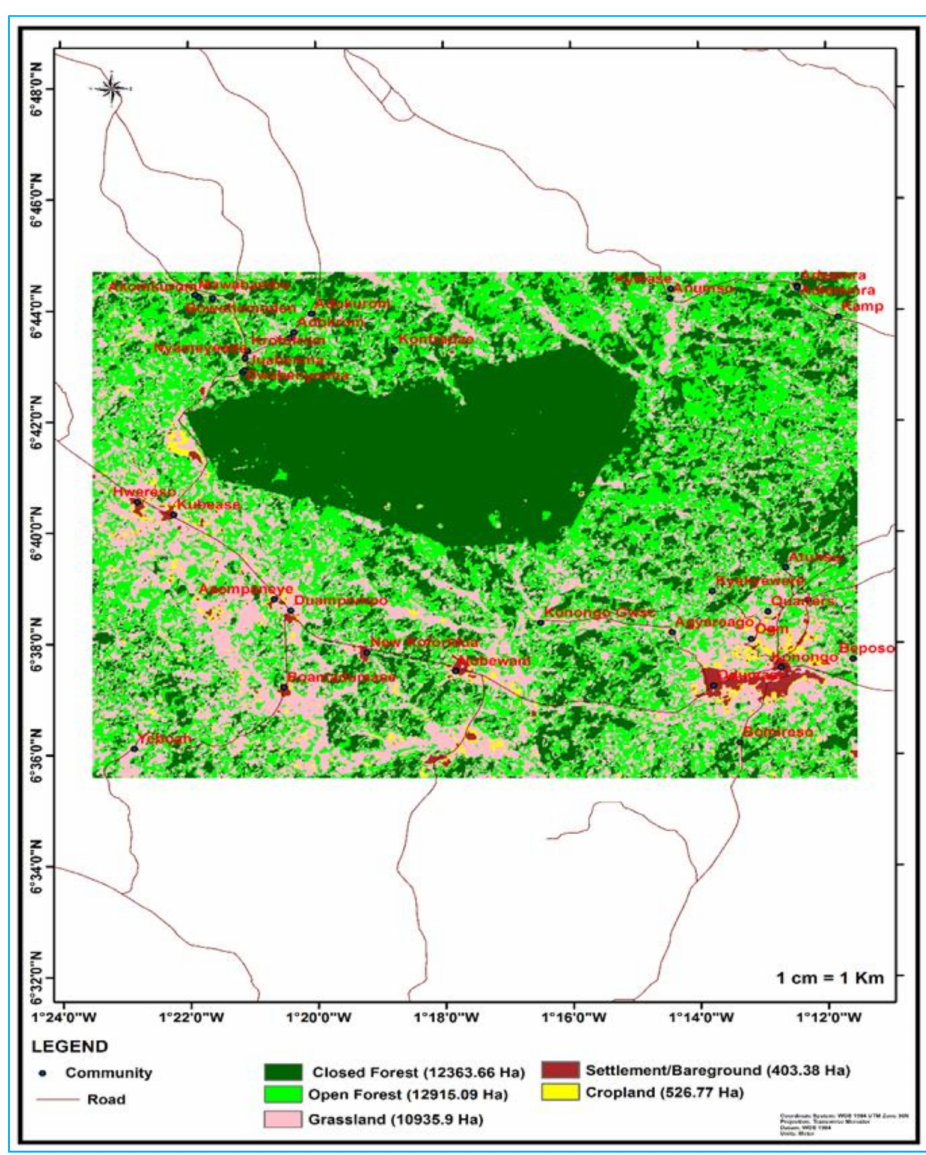
Figure 5. Landsat image of Bobiri forest reserve in 2003. Figure 6 shows the Landsat image for 2010. Crop land recorded the lowest fraction of 2.3%. The southern part constituted the highest portion of grassland. Settlement/bare ground rapidly continued to increase with time to reach 2.6% in